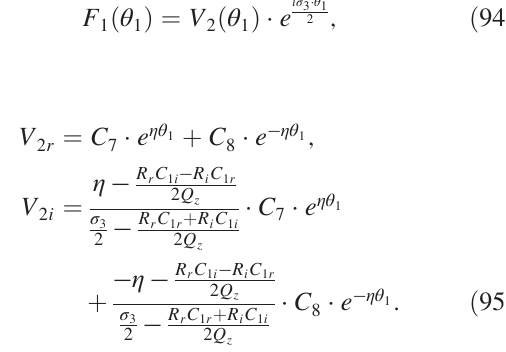
FIG. 7. Vertical oscillations obtained by the numerical method (red) and analytical formulas (blue) near Q vertical amplitude at initial radial amplitudes of (left) 2 mm and (right) 3